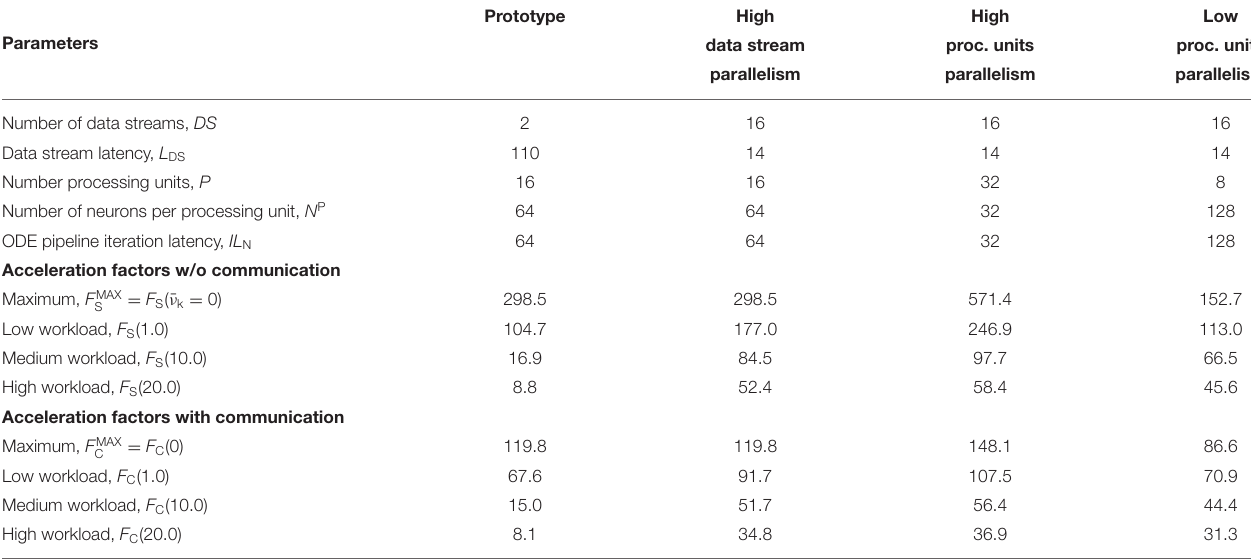
TABLE 1 | Parameter